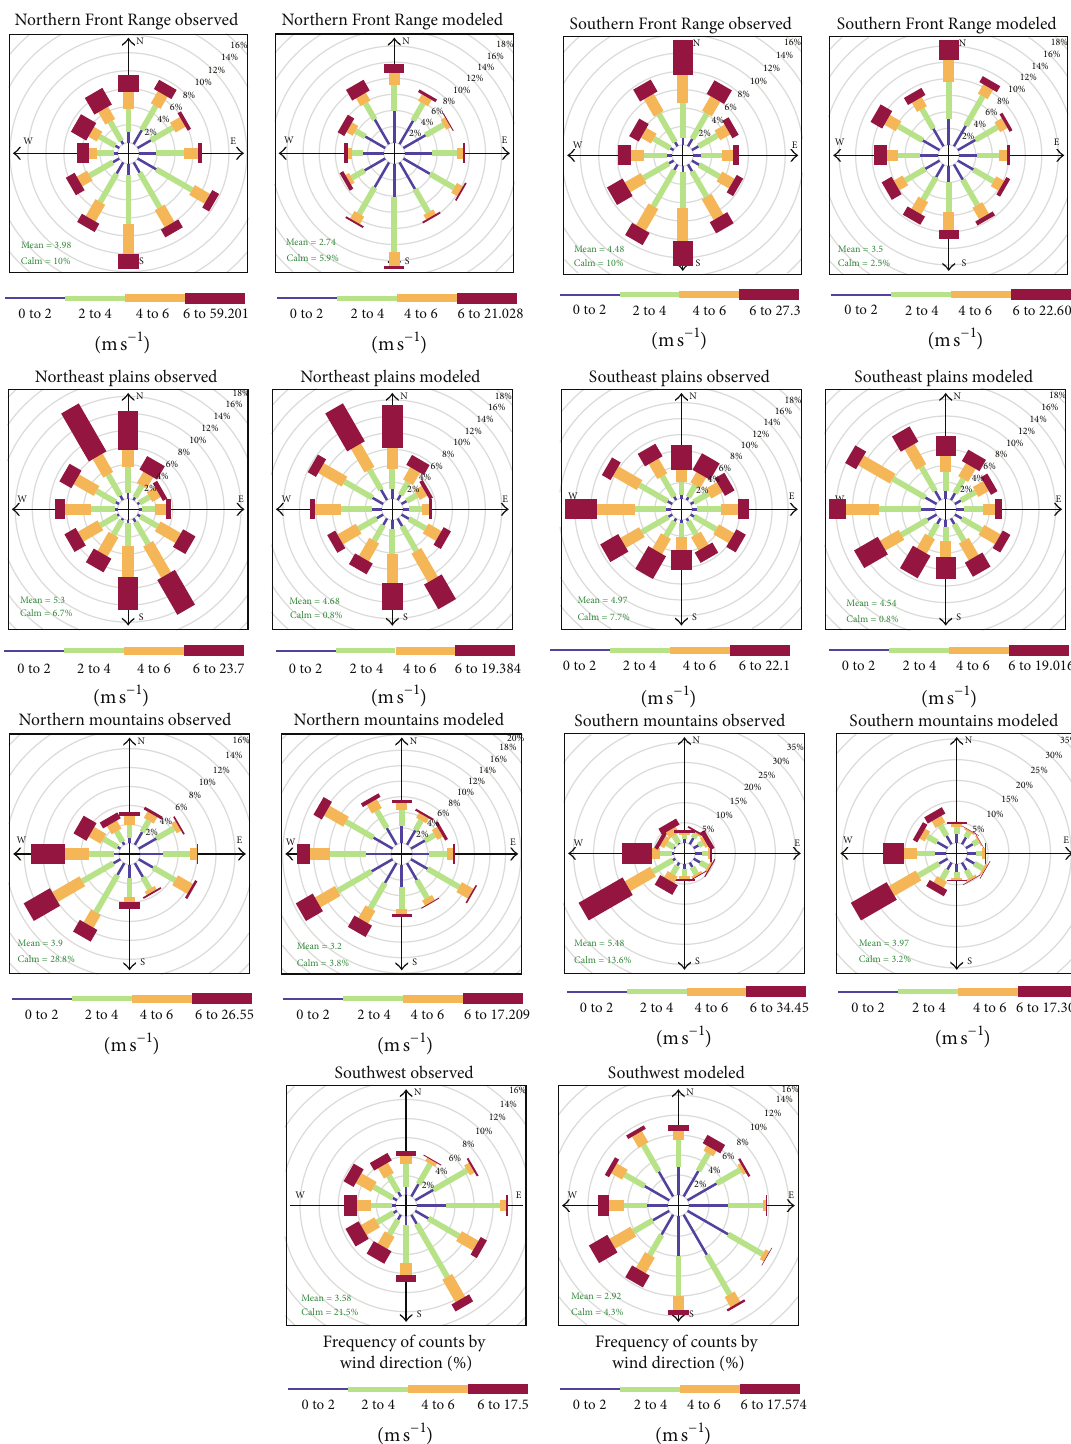
Figure 5: Wind roses for observed and modeled winds in each of seven regions in Colorado from November 2008 to November 2009. Each light gray circle represents 5% frequency. Region locations are shown in Figure